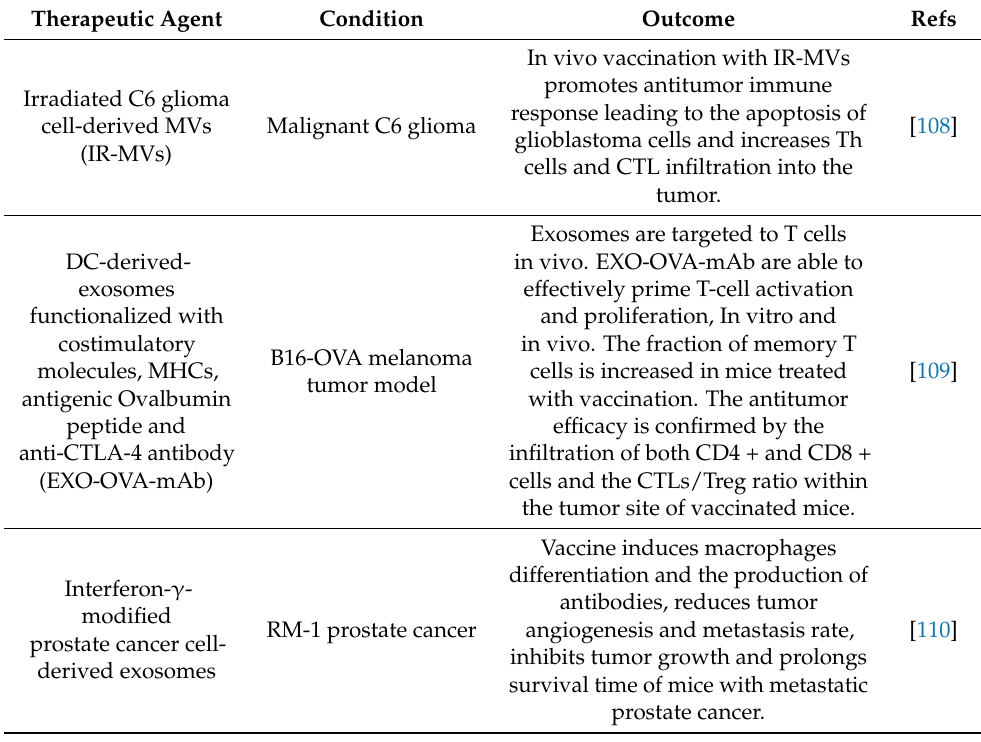
Table 3. Preclinical studies investigating the use of EVs in cancer